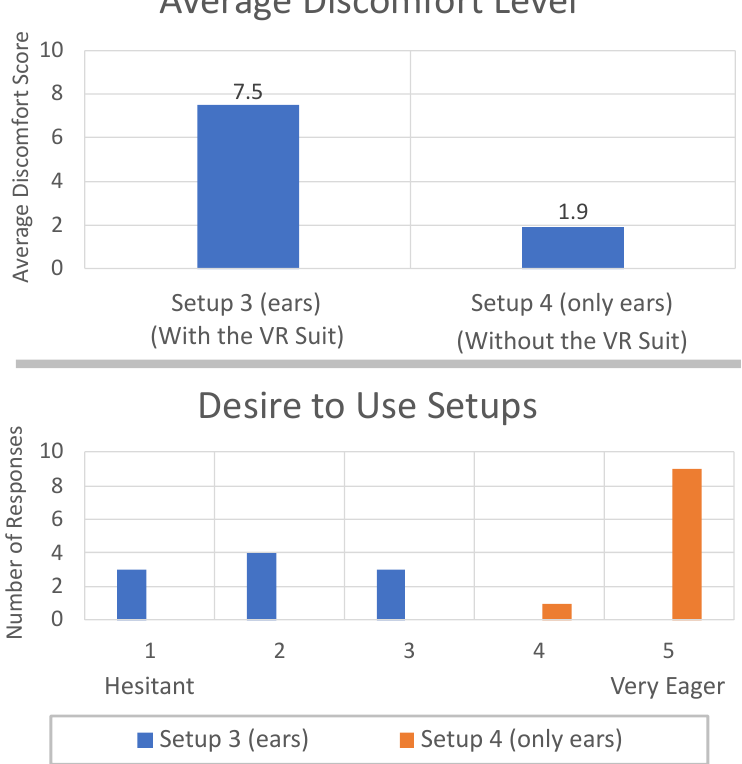
Figure 13. Results of average discomfort level and desire to use “Setup 3 (ears)” and “Setup 4 (only